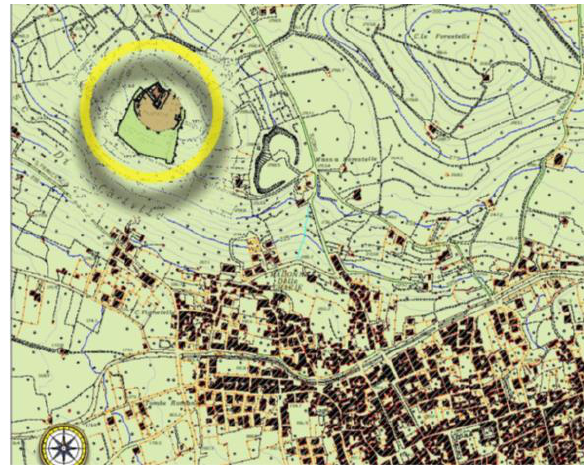
Figure 4: The map of Avella town and the fortified site. Detail.